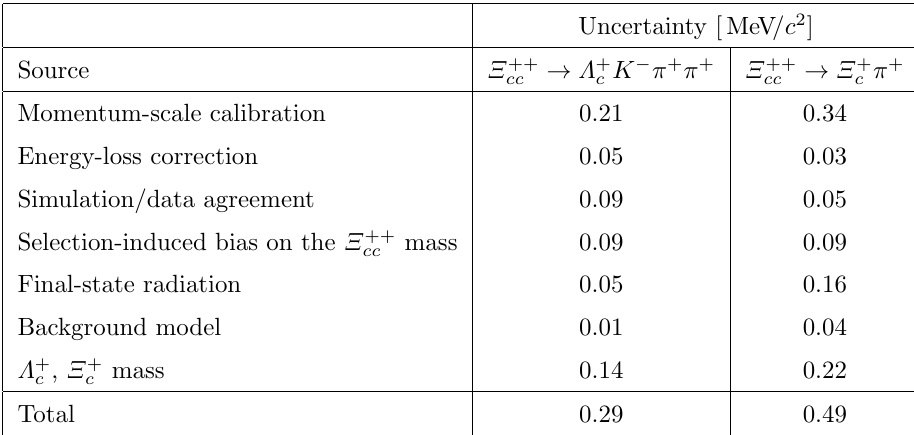
Table 1 . Systematic uncertainties on the (cid:4) ++ (cid:4) ++ ! (cid:4) + (cid:25) + decays. The total systematic uncertainty on each mode is calculated by summing the cc c individual sources of uncertainty in quadrature, except for the uncertainty on the momentum-scale calibration of the (cid:4) + mass [50], that is added linearly to that of the (cid:4) ++ c